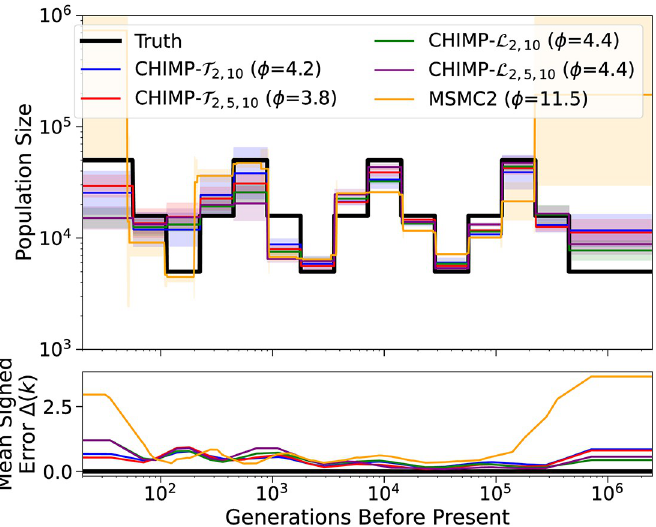
Fig 6. Results of inference in the piecewise sawtooth scenario from a sample of size n = 10 for the composite likelihood schemes CHIMP - T , CHIMP - T , CHIMP - L , and CHIMP - L . In these cases, the likelihood is 2 ; 10 2 ; 5 ; 10 2 ; 10 2 ; 5 ; 10 multiplied across non-overlapping subset of the respective sizes, and multiplied across sizes. We present results obtained using MSMC2 for comparison. We infer the population sizes in the intervals, fixing the change points to match the truth (shown in black). Solid lines are averages over 16 replicates and the standard deviation is indicated by the shaded areas. Mean signed error Δ ( k ) is shown in bottom plot and has been smoothed using moving average for visualization purposes. The integral ϕ is indicated in the legend. Note that MSMC2 groups epochs in the very distant past due to limits of the method